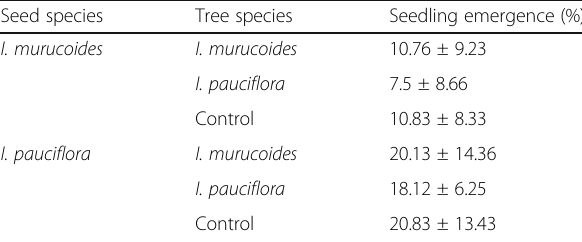
Table 3 Percentage of seedling emergence ( X ± SD) of Ipomoea murucoides and I. pauciflora sown below trees of I . murucoides and I. pauciflora and in the control area